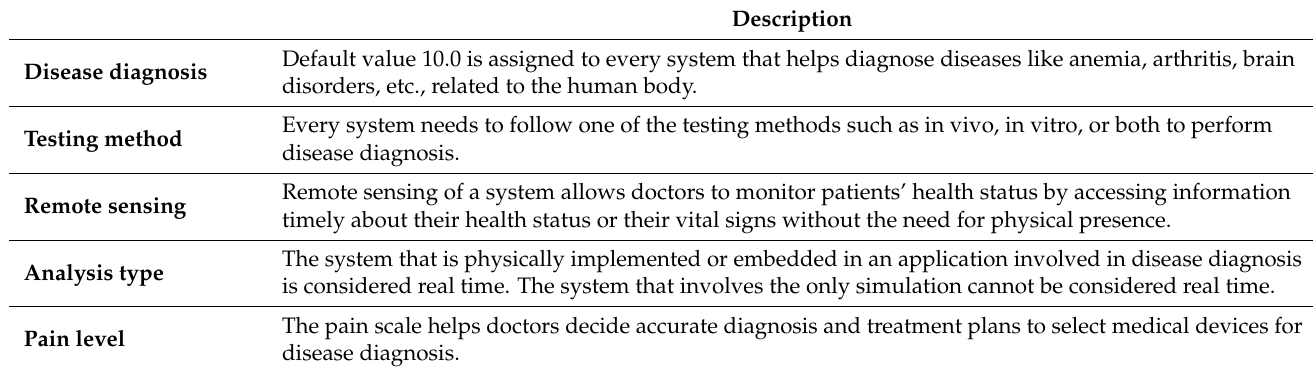
Table 1. Parameters considered for system